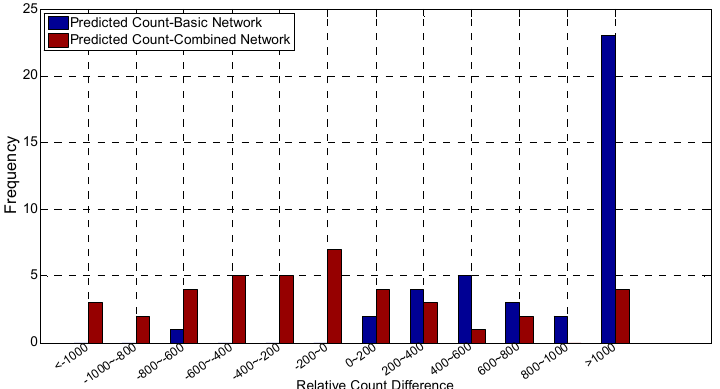
Figure 12. Distribution of count errors for the Basic Network and Combined Network.